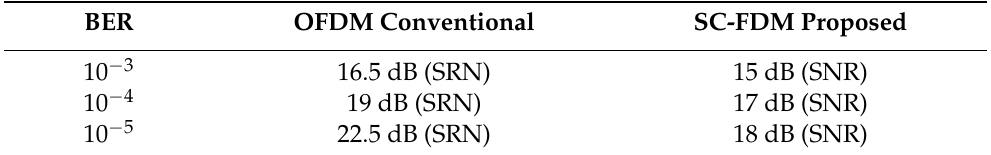
Figure 16. BER vs. SNR comparison of the proposed SC-FDM and SC-LMS communication system for the A c with N p = 16, FFT = 256 and BW = 64 kHz, 8 QAM, F c = 150 kHz. 5 Table 4. Raw bit error rate performance